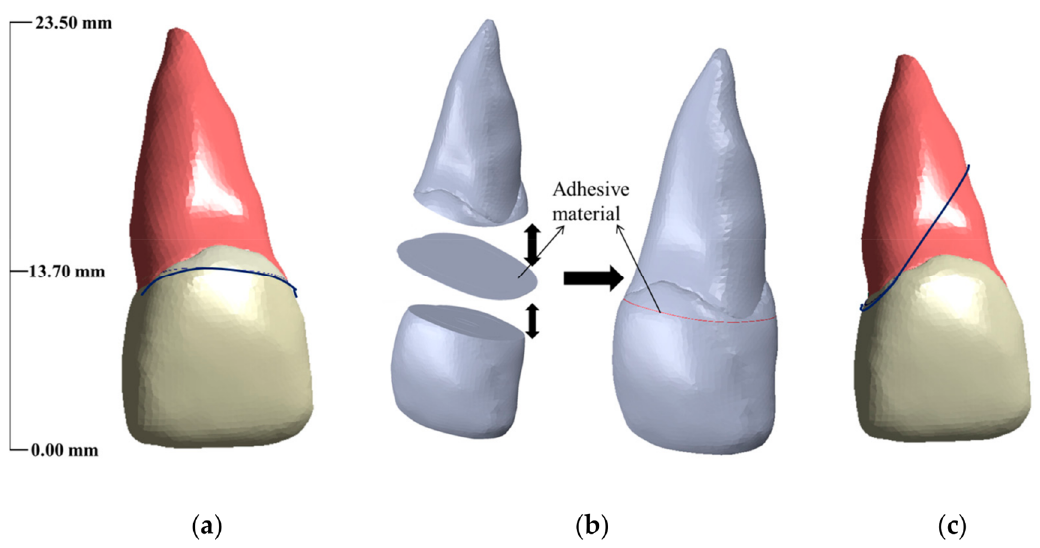
Figure 2. Fracture models: ( a ) Crown, ( b ) Crown fracture with adhesive material, and ( c )